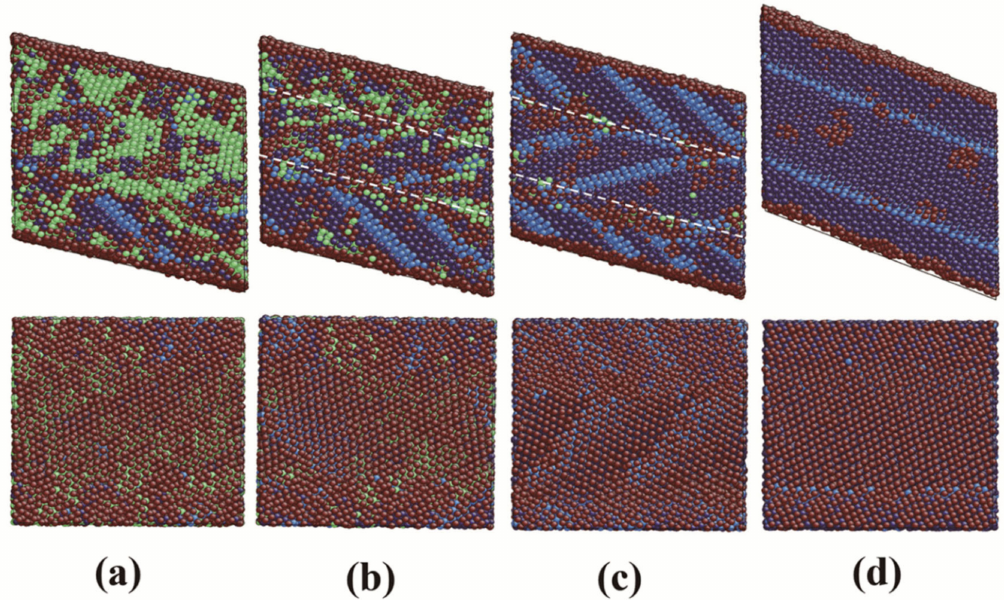
Figure 11. Snapshots of the ongoing austenitic phase transition in film 3 at 800 K. The colors denote the local crystal structure as in Figure 5. In a–d, the upper figures show the original (211) bcc plane and the lower figures demonstrate the original (111) bcc surface. The white dashed lines in b and c separate the fcc phases nucleated at the free surfaces and in the bulk material. ( a ) Status at a shear angle of 14 ◦ . New fcc phases nucleate at the free surface and in the bulk material; ( b ) Status at a shear angle of 15 ◦ ; Growths of the fcc phases; ( c ) Status at a shear angle of 16.5 ◦ . The phase transition is almost finished; ( d ) Status at the largest shear angle of 26.5 ◦